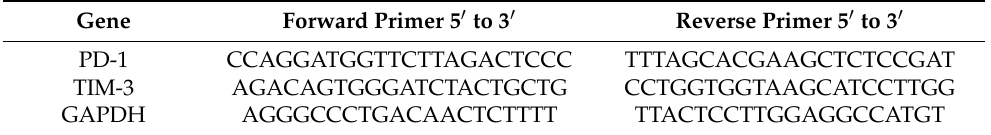
Table 1. Primer sequences used for